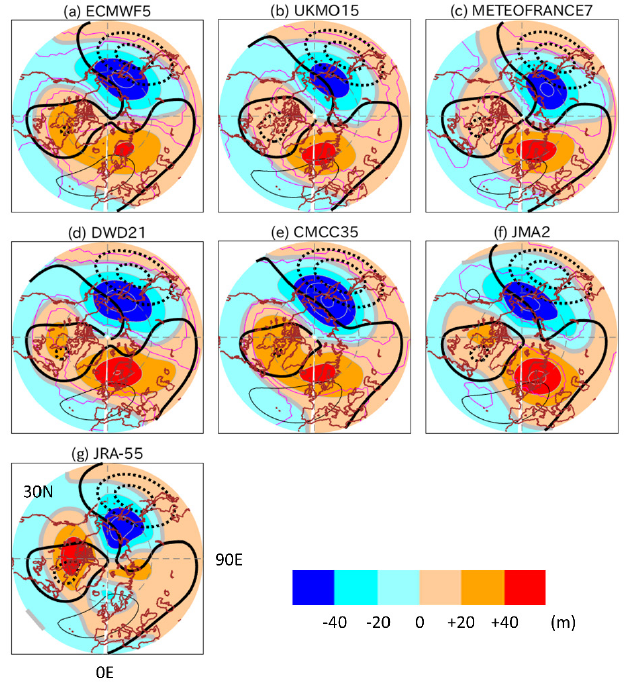
Figure 4. Ensemble mean composite maps of 500 hPa GPH anomalies for the HC and JRA-55 data, averaged from lag = −10 to 0 day of the MSSW central date (color shades) ( a – g ). Contour interval is 20 m. Only waves 1–3 components are retained. Magenta contours in ( a – f ) denote statistically significant anomalies at the 95% confidence level. Black contours show the waves 1–3 field in the DJF climatology in each data. Contour interval is 100 m. Solid black contours are for positive values (thick for zero), and dotted contours are for negative values. A similar examination for the 10 hPa GPH around the MSSW onset date, i.e., from lag = −2 to +2 days, shows prevailing positive anomalies over the polar region for all systems and JRA-55 data, implying a weakening of the polar vortex (Figure 5). The positive anomalies have larger magnitudes for CMCC35 and JMA2, consistent with Figure 2d, as the climatological polar vortex is stronger for the two systems than for the other systems and JRA-55 data.